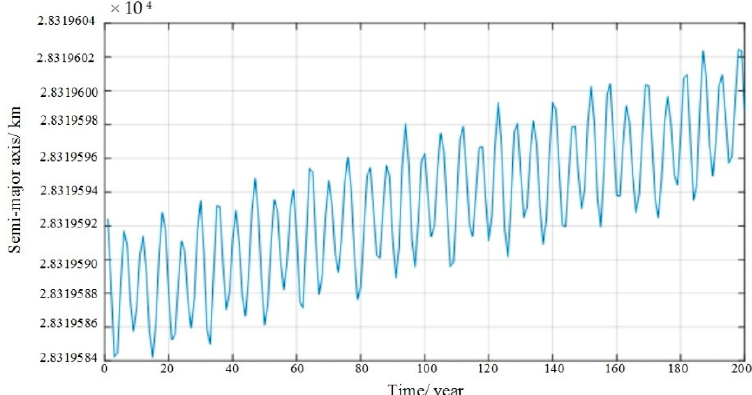
Figure 17. Variations in the semimajor axis of the optimal disposal orbit.